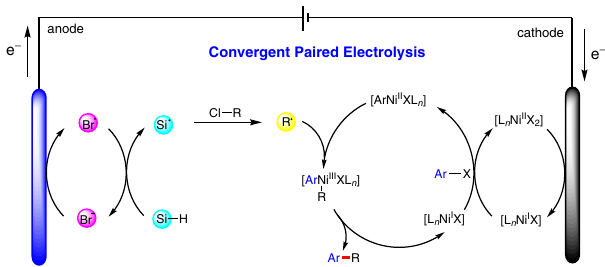
Fig. 4 | Plausible mechanism. The electrophilic alkyl radical from the α -carbonyl chlorideis formedvia XATand HAT processes inthe anode.Cathodicreduction of Ni II X 2 L n species leads to Ni I XL n species, which undergoes the oxidative addition of aryl halides. The capture of the alkyl radical by Ni I XL n species delivers an (alkyl) (aryl)Ni III XL n species, then rapid reductive elimination yields product 2 and regenerates the Ni I